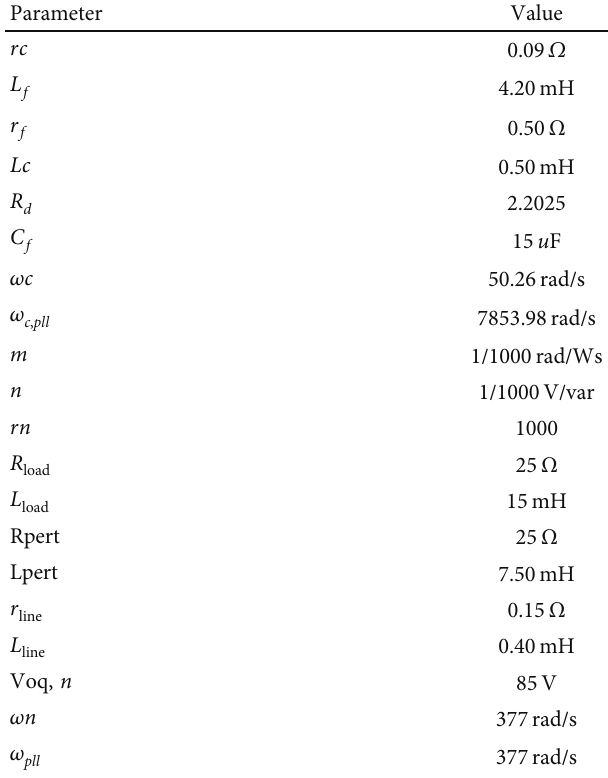
Table 1: Parameter